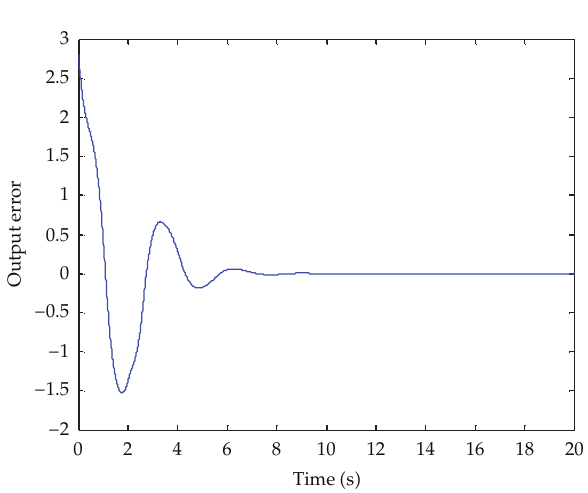
Figure 6: The error output state between master and slave systems.